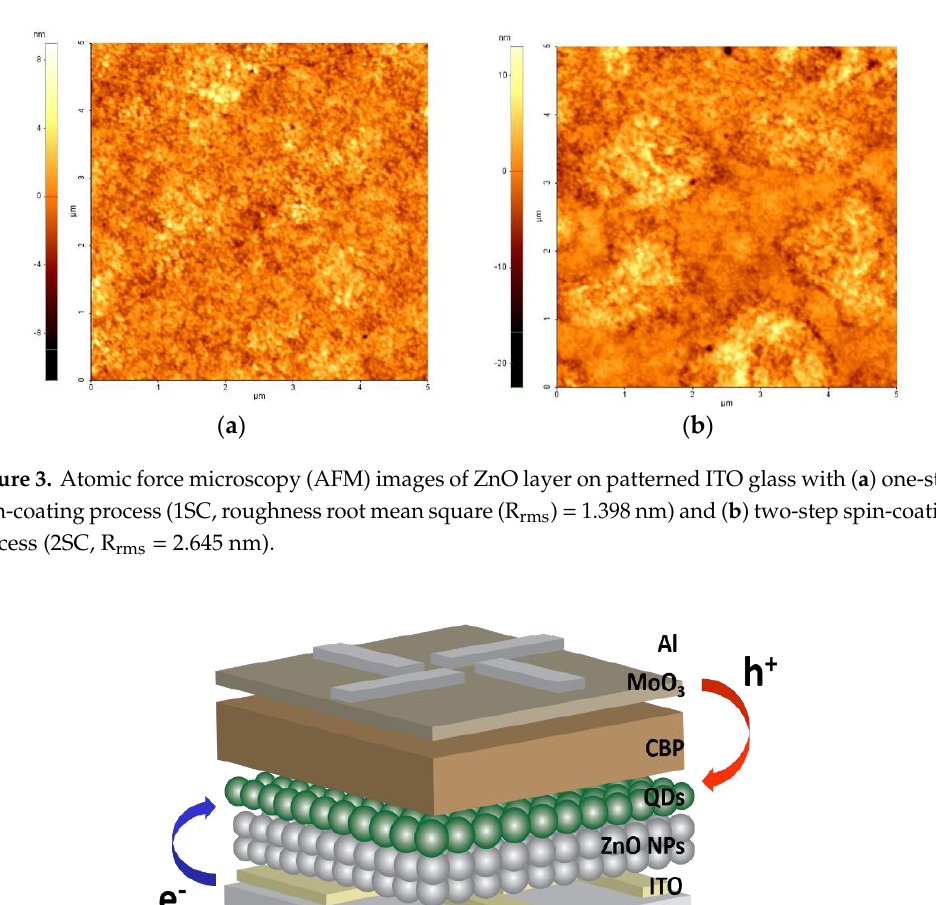
( b ) Figure 1. ( a ) transmission electron microscopy (TEM) image and ( b ) X-ray diffraction (XRD) pattern of ZnO nanoparticles (NPs). ( a ) ( b ) Figure 2. ( a ) Schematic description of two different spin-coating processes for the electron transport layer (ETL) using ZnO NPs and ( b ) transmittance spectra of ZnO layers on patterned ITO glass